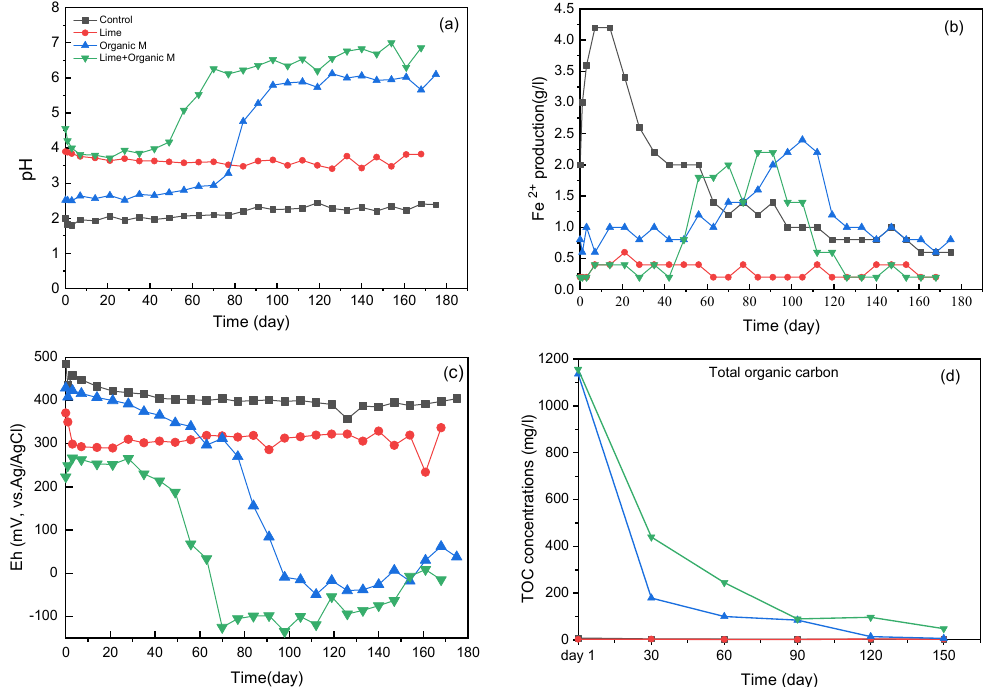
Figure 7. pH value ( a ), Fe 2+ concentration( b ), Eh ( c ), total organic carbon ( d ) in the solutions from the four columns during the experiment of the four columns (control, Lime, OM, and Lime + OM), respectively.